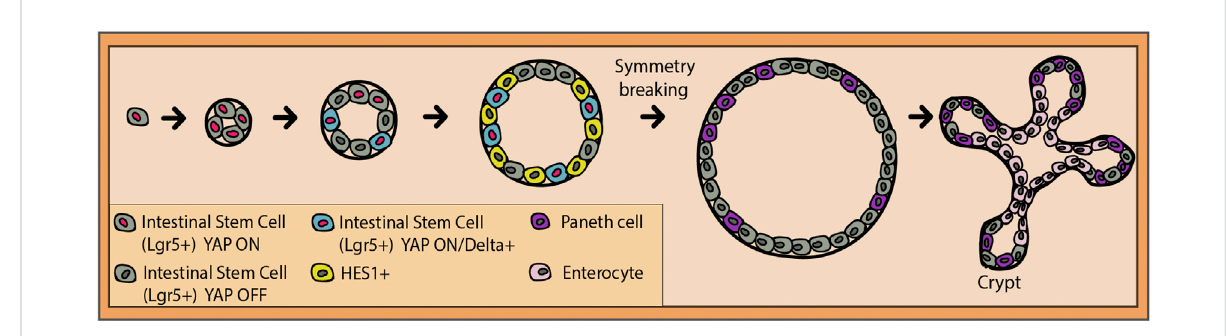
FIGURE 4 Transition from a single intestinal stem cell (gray) to an intestinal organoid. Transcription factor YAP is active in all stem cells until the four-cell stage (red nucleus). Presumably, due to physically increasing crowding of the stem cells, some of them will export YAP into the cytoplasm where it gets deactivated (dark gray nucleus). The ones that still maintain YAP ON will gradually start to express Delta (blue cells with red nucleus), and their neighbors will express a Notch target, HES1 (yellow cells with dark gray nucleus). Entering the 16 – 32-cell stage, the Delta-positive cells lose their nuclear YAP and are ready to commit to the Paneth cell fate. This event breaks the symmetry of the organoid and pushes the formation of the intestinal crypt (niche), where stem cells and Paneth cells